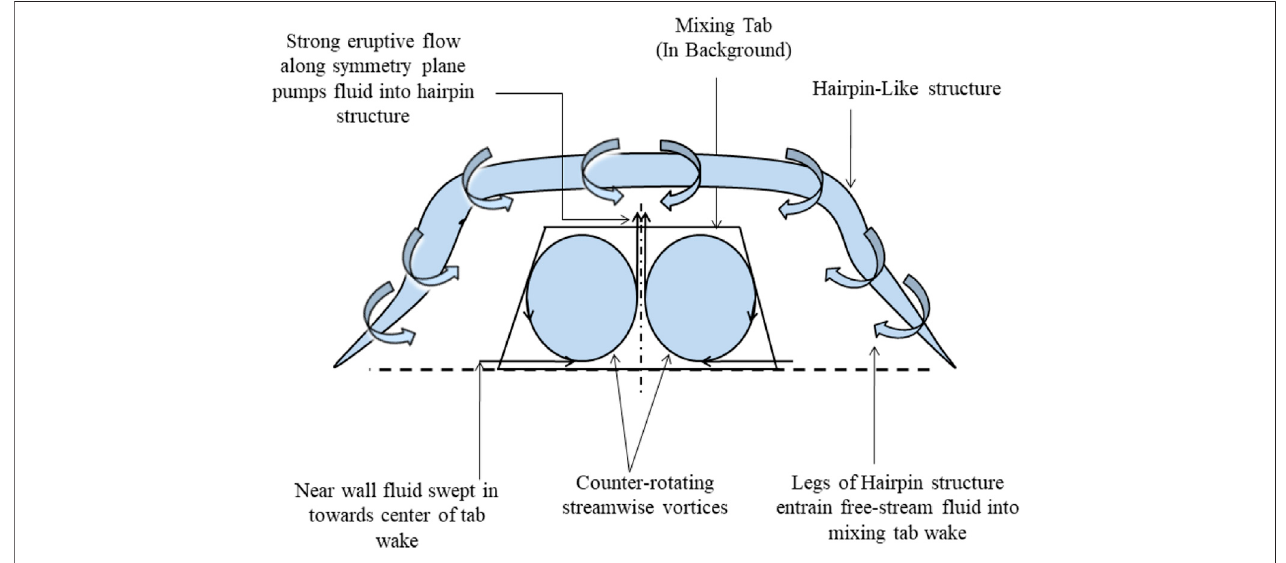
FIGURE 6 | Fluid movement from the surface to the wake of the tab